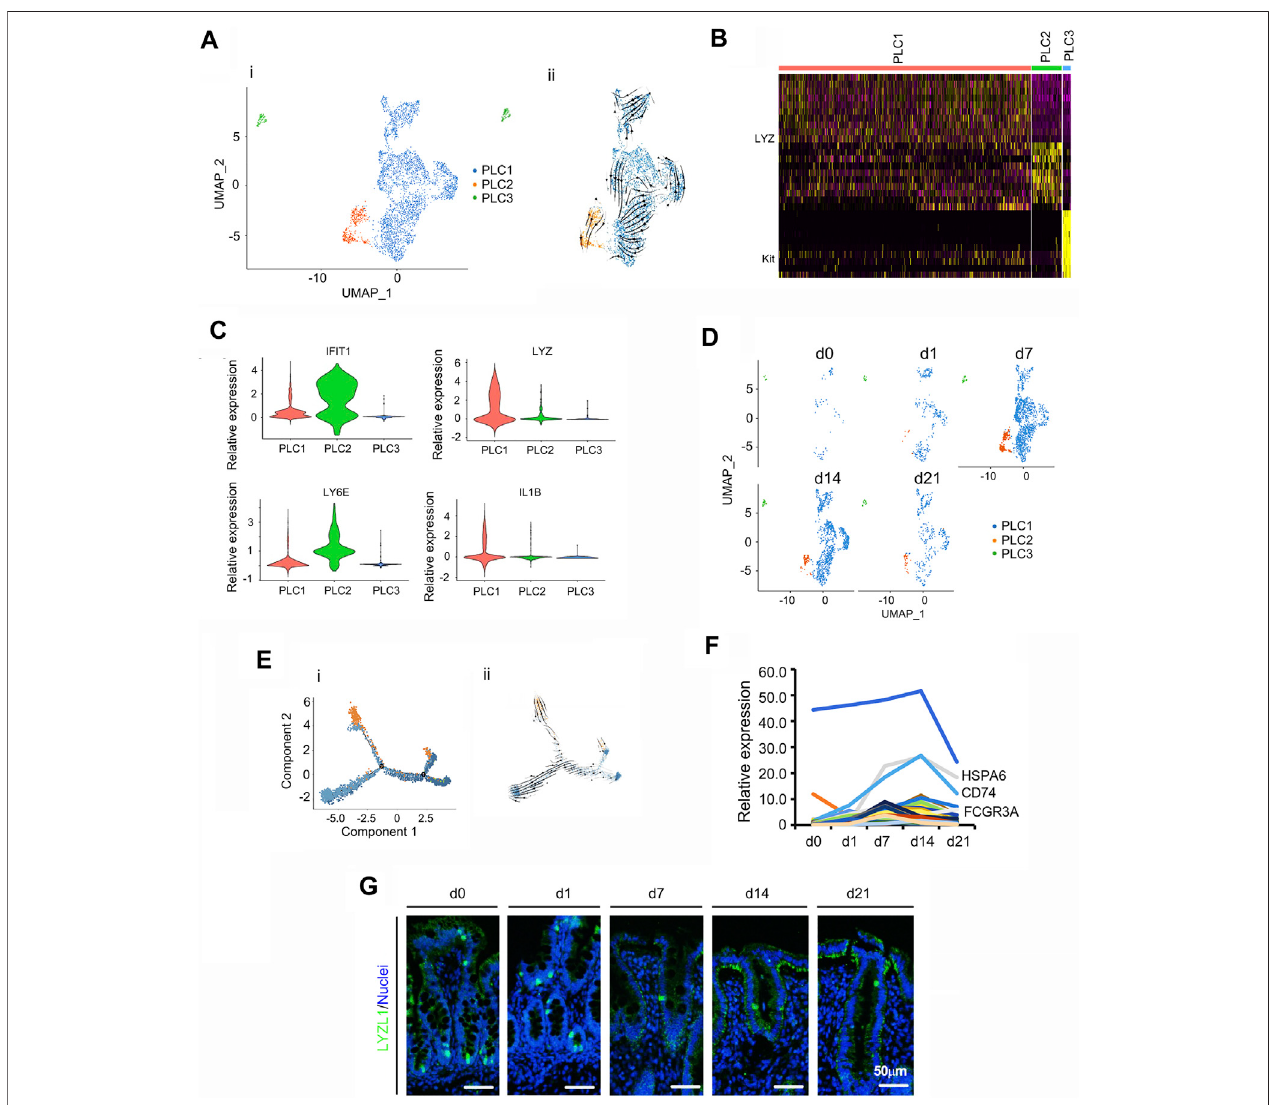
FIGURE 5 | Summary of scRNA-seq data for Paneth like cells (PLCs). (A) Cell type clusters for PLCs for the cells together from the fi ve time points by UMAP. (i) UMAP of PLCs single cells (points), colored by cluster assignment. (ii) RNA velocity vector projection on UMAP plot (The arrow indicated the developmental trend). (B) The heatmap of the top 25 marker genes in each cluster of PLCs. (C) Expression pattern of marker genes in different clusters of PLCs. (D) Decreasein PLCs population during development(fromd0tod21). (E) Trajectory reconstruction ofPLCsbasedoncell clustersfollowingpseudotimeanalysis.(i).Monocleplot. (ii).RNAvelocity vectorprojectionon amonocleplot(The arrow indicatedthedevelopmental trend). (F) Therelative expression pattern ofthetop50speci fi callyexpressed genesinPLC. The gene level was based on the expression of each gene in all the cell, and it is relative level from scRNA-seq analysis. The Y-axis presents the relative expression, and X-axis shows the time points. (G) Protein levels of LYZL1 in the different samples at different time points according to IHF. Scale bar: 50 μ m.